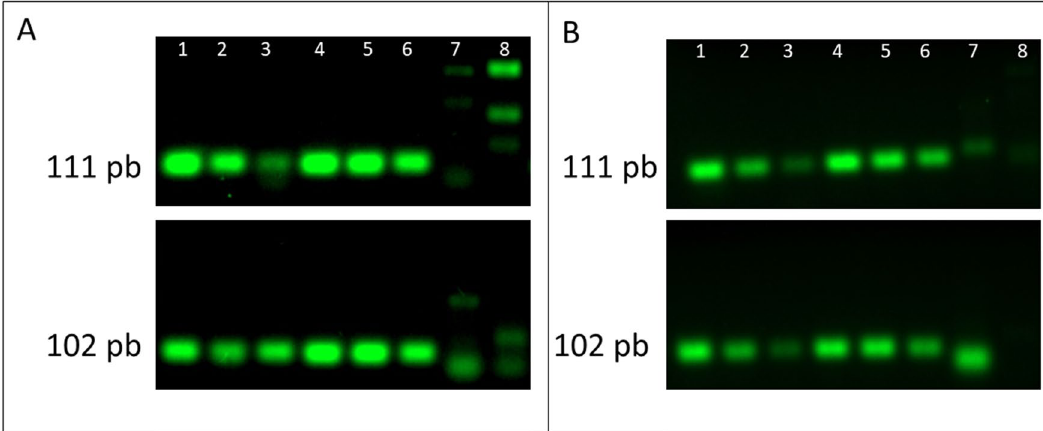
Figure 4. Real-time PCR amplicons of SARS-CoV-2-positive samples after separation by 2% agarose gel electrophoresis. The 111 bp amplicon generated by RT-PCR with the hCOVassay1 primer set (upper figures) and the 102 bp amplicon generated with the hCOVassay2 primer set (lower figures). ( A ) Amplicons produced by RT-PCR without UDG activation. ( B ) Amplicons produced by RT-PCR with UDG activation. Lanes 1–3: 500 ng, 100 ng and 50 ng, respectively, of the first-strand DNA synthesized using the 3 ′ primer followed by PCR amplification. Lanes 4–6: 100 ng, 50 ng and 10 ng, respectively, of the first-strand DNA followed by RT-PCR amplification. Lanes 7 and 8 are negative controls. The gels were cropped for improving the quality and clarity of image. Full gels are presented in Supplementary Figs. S4 and S5.